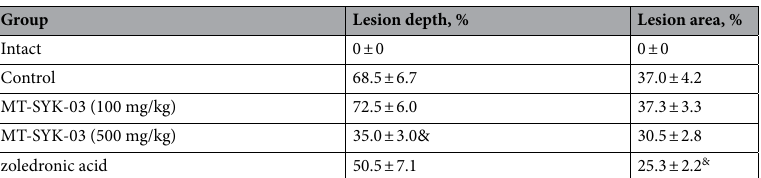
Table 2. The area and surface of a lesion of cartilage tissue after meniscectomy on day 21. & Statistically significant (p < 0.05) compared with the control